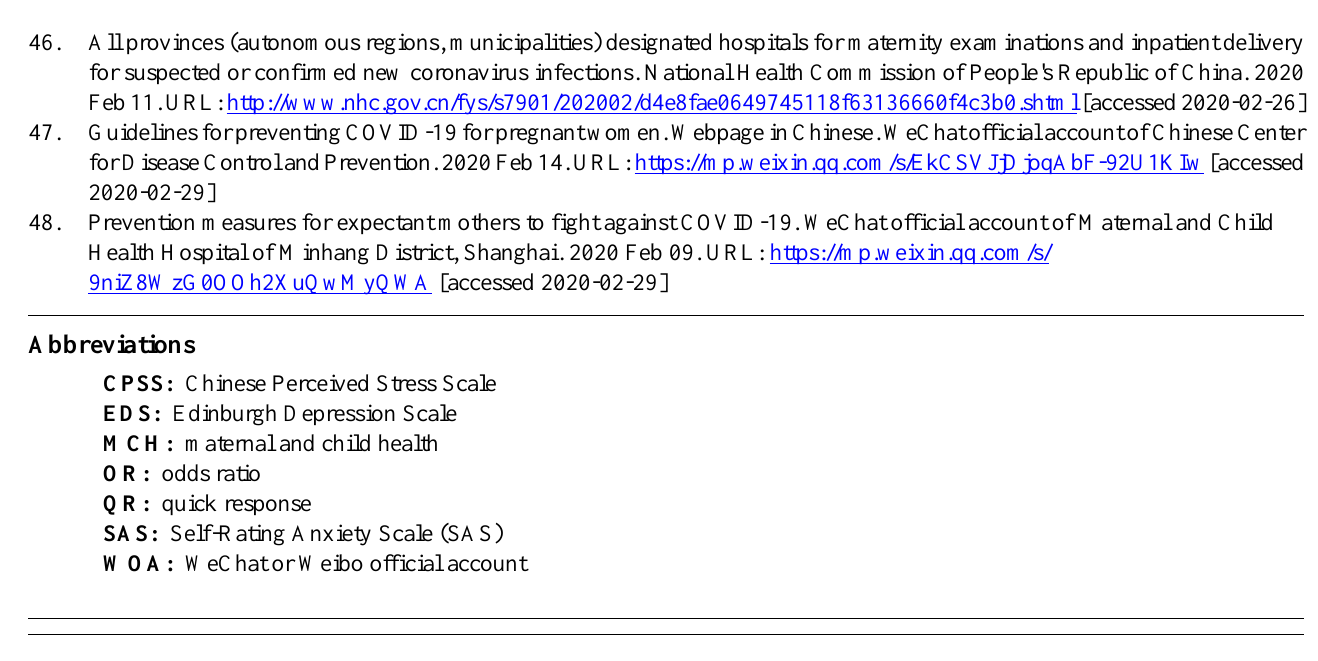
All provinces (autonomous regions, municipalities) designated hospitals for maternity examinations and inpatient